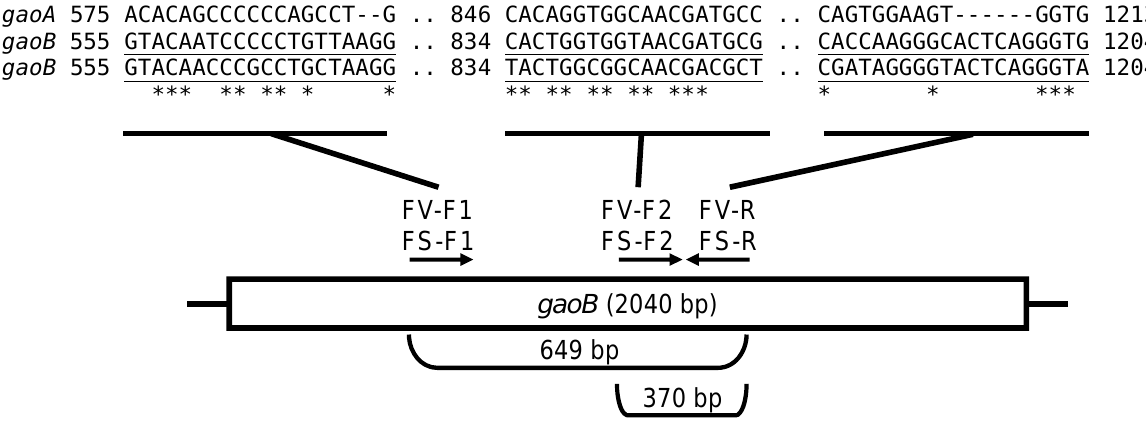
oxidase-coding gaoA gene from F. austroamericanum ( F. a.— GenBank M86819) and the gaoB gene from F. verticillioides ( F. v. —GenBank HM069186) and F. subglutinans ( F. s. —GenBank HM069185) is shown above the positions of the designed primers regarding the gaoB gene from F. verticillioides and F. subglutinans . The primers sequences are underlined and the orientations are indicated by the arrows. The amplicon’s size is indicated on the bottom. F.a. gaoA 575 ACACAGCCCCCCAGCCT--G .. 846 CACAGGTGGCAACGATGCC .. CAGTGGAAGT------GGTG 1213 F.v. gaoB 555 GTACAATCCCCCTGTTAAGG .. 834 CACTGGTGGTAACGATGCG .. CACCAAGGGCACTCAGGGTG 1204 F.s. gaoB 555 GTACAACCCGCCTGCTAAGG .. 834 TACTGGCGGCAACGACGCT .. CGATAGGGGTACTCAGGGTA